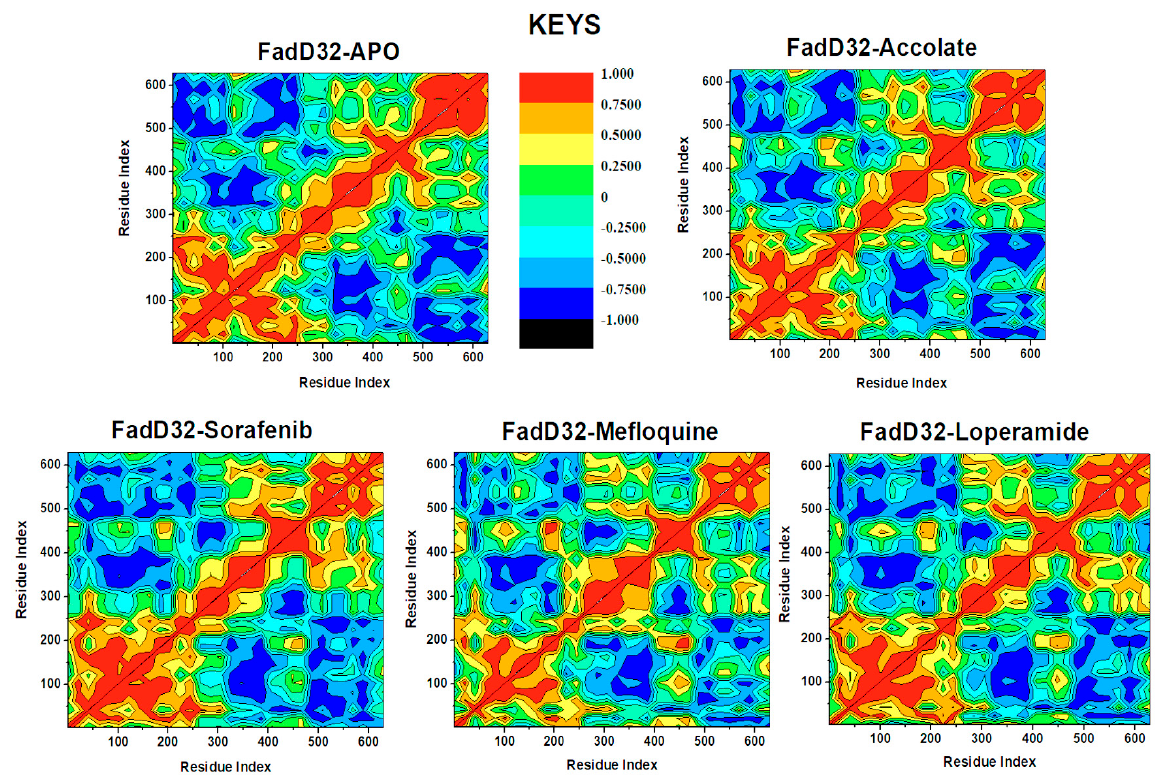
Figure 8. DCCM analysis graphs of the FadD32-Apo, FadD32-Accolate, FadD32-Sorafenib, FadD32- Mefloquine, and FadD32-Loperamide.